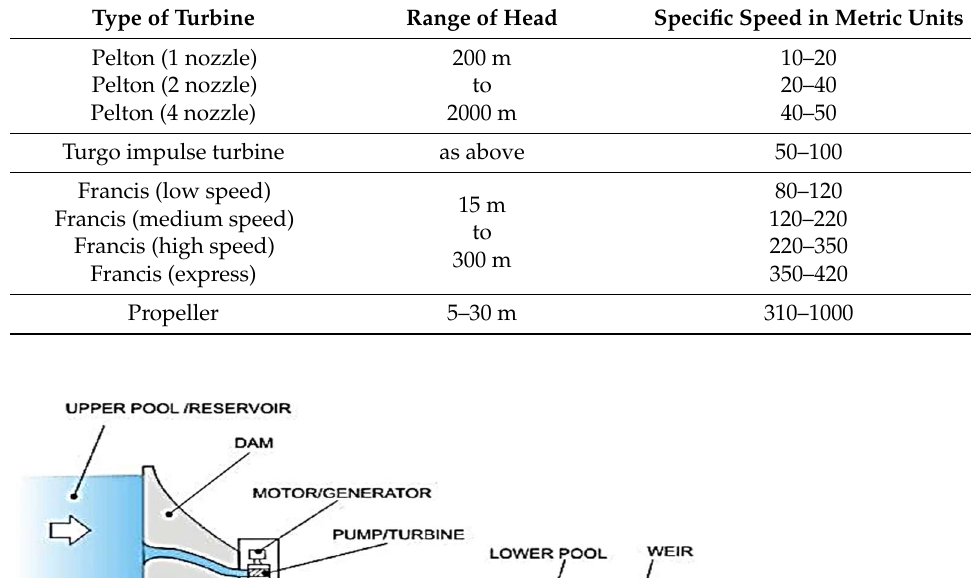
Table 2. Recommended turbine types related to water head [50].